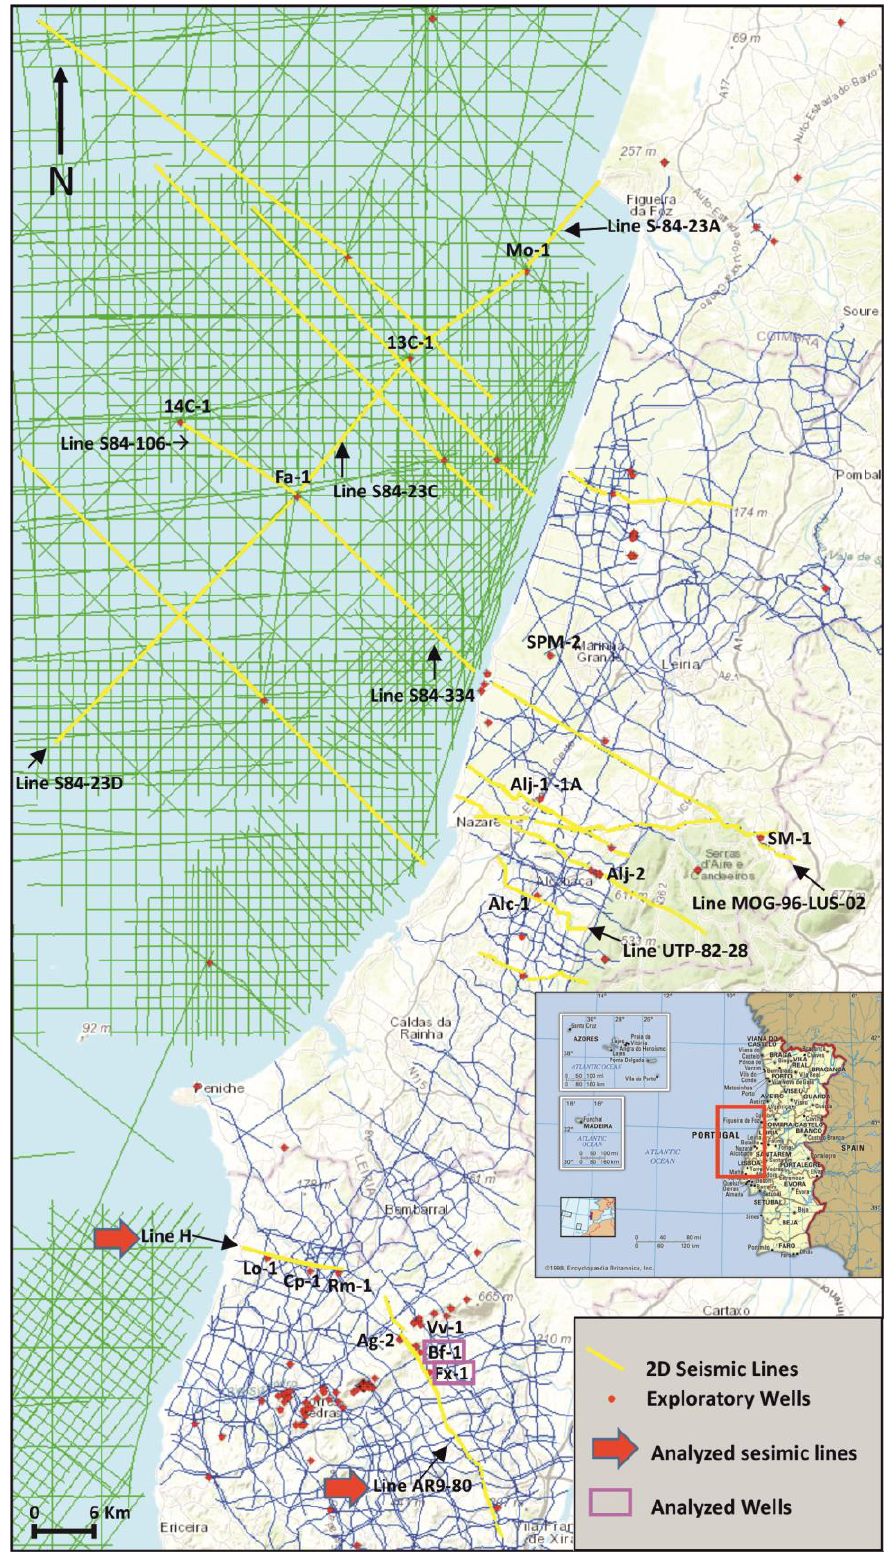
Figure 8. Location map of the 2D analyzed seismic lines H and AR9-80. This last line with the analyzed exploration wells Freixial-1 (Fx-1) and Benfeito-1 (Bf-1), adapted from Ref. [16], was selected to be presented in the